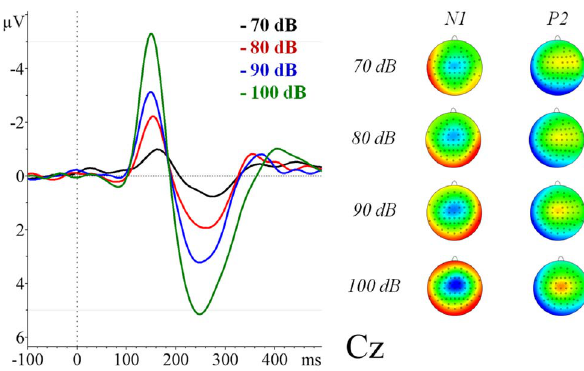
Figure 1. Grand average (n=16) of the auditory evoked related potentials for the different sound pressure levels at Cz measured inside the scanner.